Question: Name the type of graph shown.
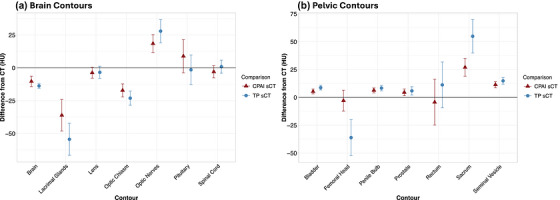
Answer: bar